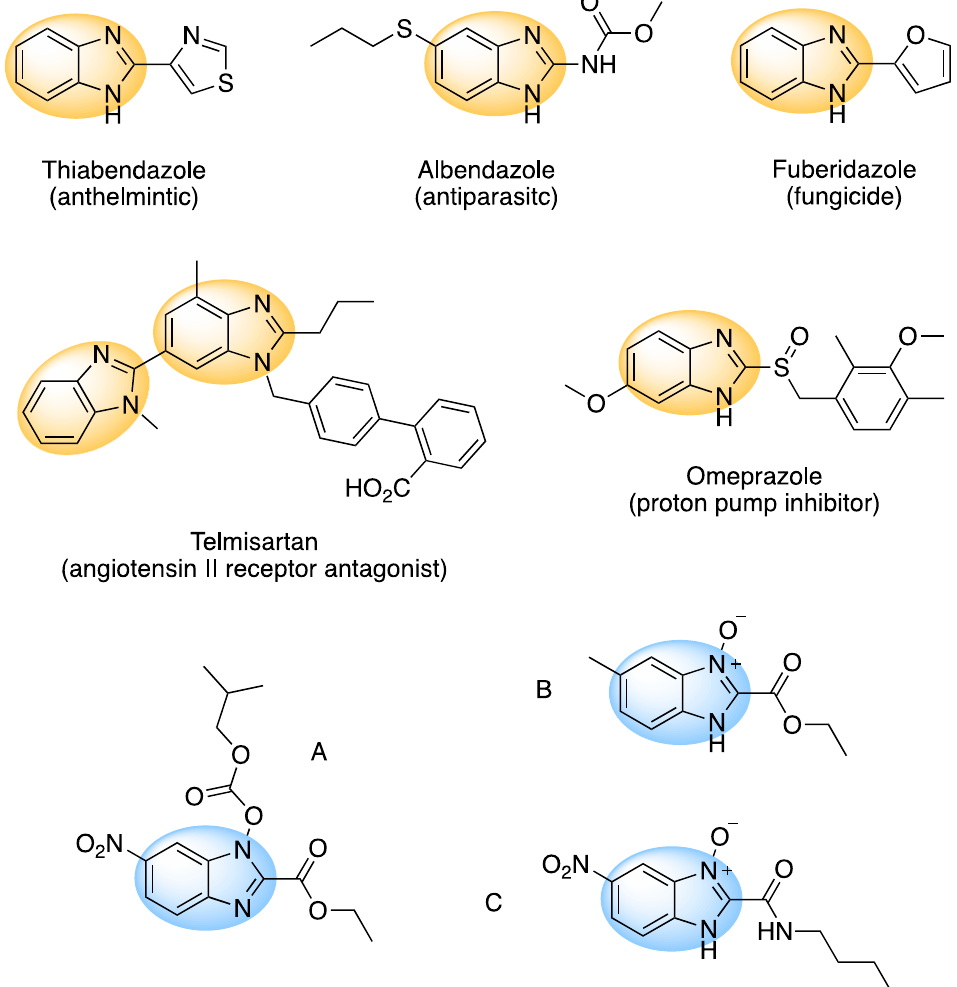
Figure 1. A range of pharmaceuticals containing the benzimidazole motif (highlighted in yellow). A, B, and C are compounds bearing the benzimidazole N -oxide motif (highlighted in blue) that show anti-protozoa activity.